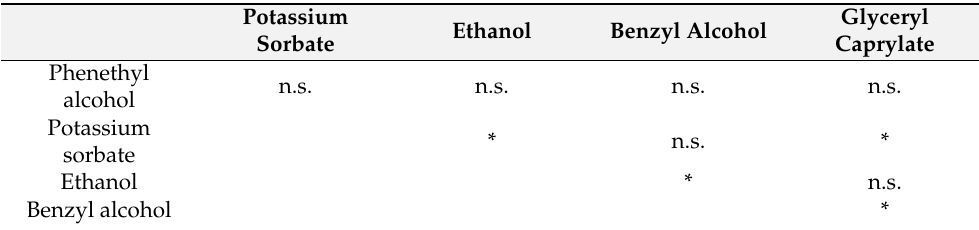
Table 3. Significance of oxygen uptake (mg O 2 /100 g) depending on used preservative after 96 days at 30 ◦ C under light exposure between two samples using one-tailed two-sample t -test for different variances ( α < 0.05 = *, not significant = n.s.).